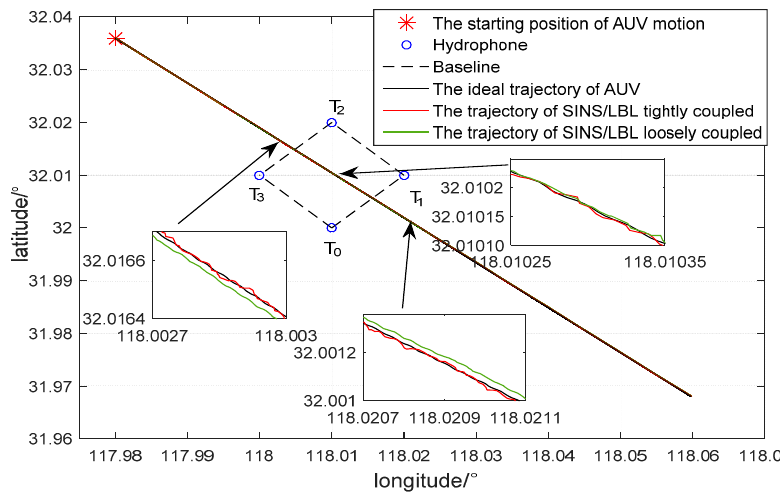
Figure 10. Simulation of SINS/LBL dynamic path.